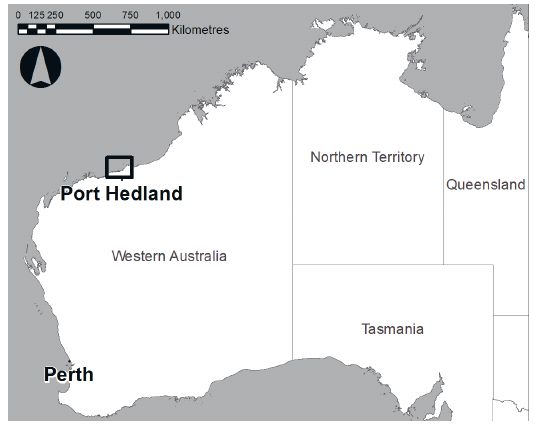
Figure 1. Location of study area, Port Hedland, Western Australia.